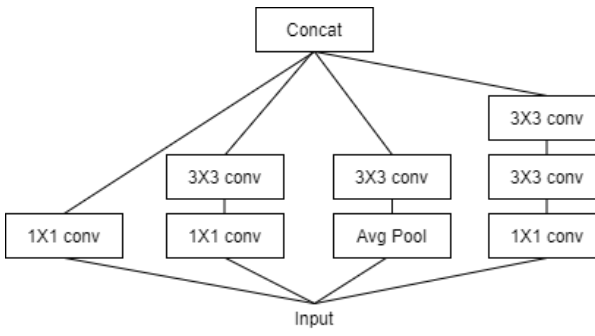
Figure 7. Architecture of Inception V3 Model.